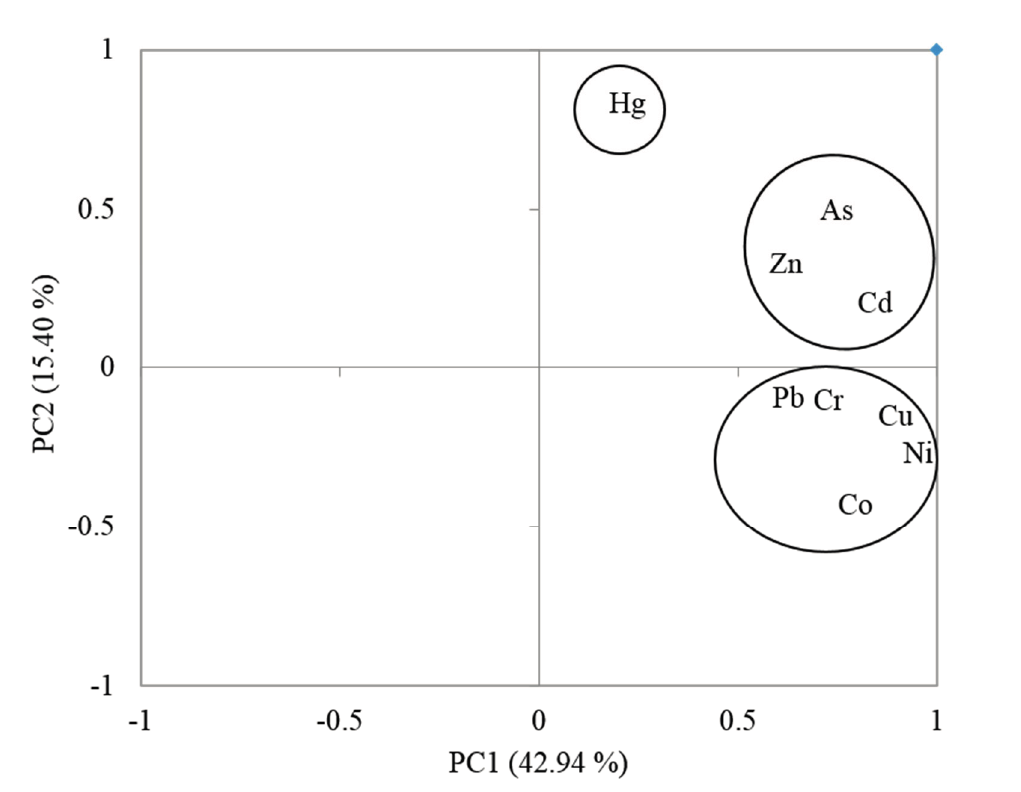
Figure 2. Distribution pattern of metals in agricultural soils in Tarkwa characterized by